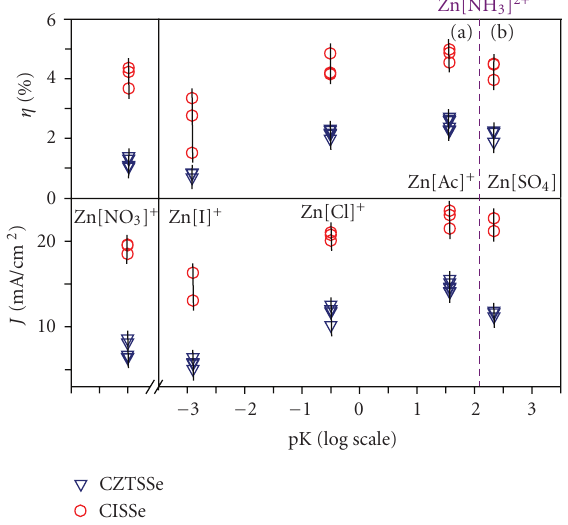
Figure 4: Current densities and e ffi ciencies of CISSe (red) and CZTSSe (blue) MGL solar cells versus Zn-complex instability constant values from various zinc precursors. The dashed line indicates Zn[NH 3 ] 2+ complex line, which divides the graph to two and (b) pK regions: (a) pK > pK > pK Zn(NH3)2+ Zn(L) n Zn(L) n Zn(NH3)2+